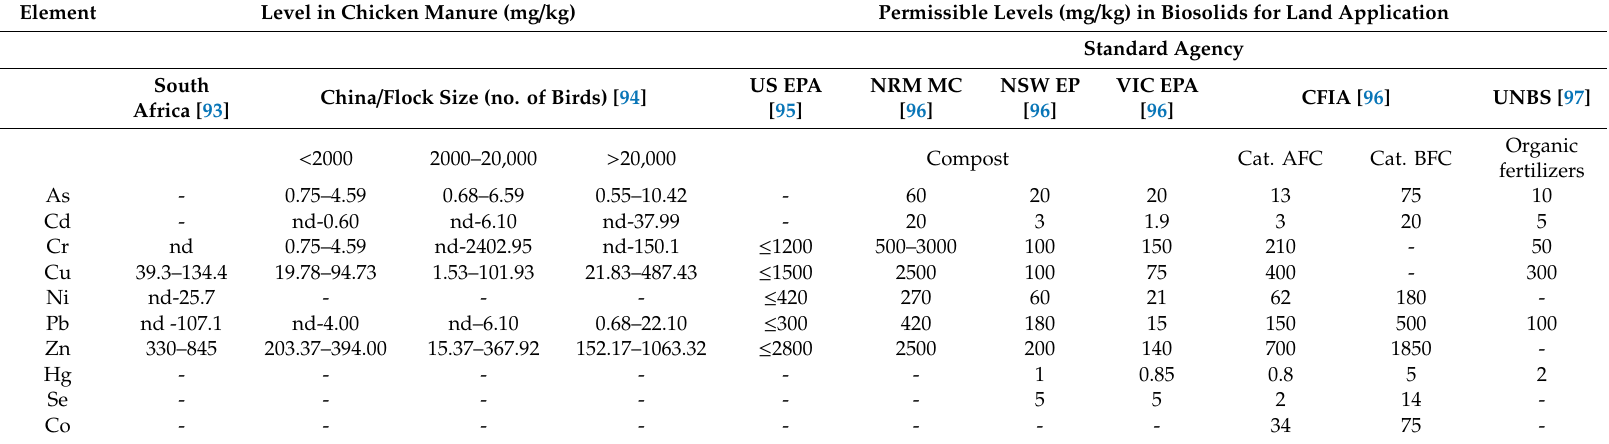
Table 9. Heavy metal levels in chicken manure and permissible levels in manure for soil application.